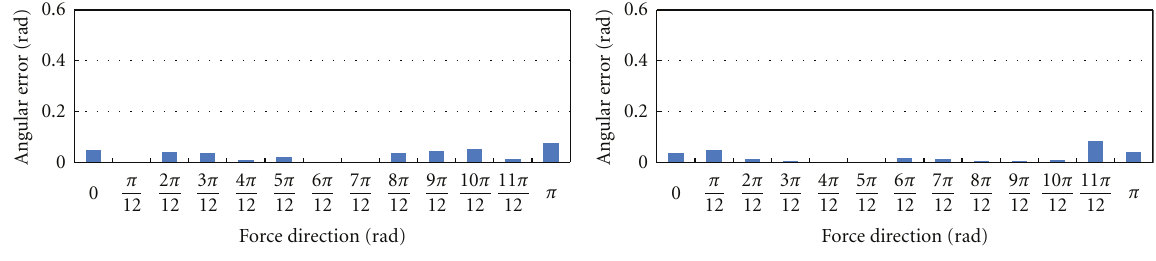
(b) Average value of the angular error in the vertical direction (M2) Figure 10: Performance of HIRO III (angular error of the presented